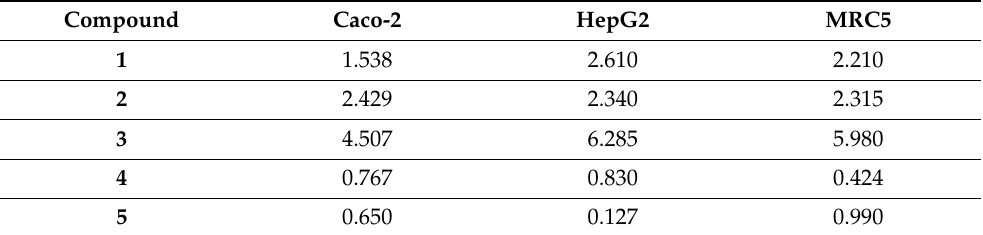
Table 1. Values of IC 50 ( µ M) for Caco-2, HepG2 and MRC5 cells treated for 24 h with different concentrations of compounds. Each SE value (not shown) is less than 10% of the calculated IC 50 value. Compound Caco-2